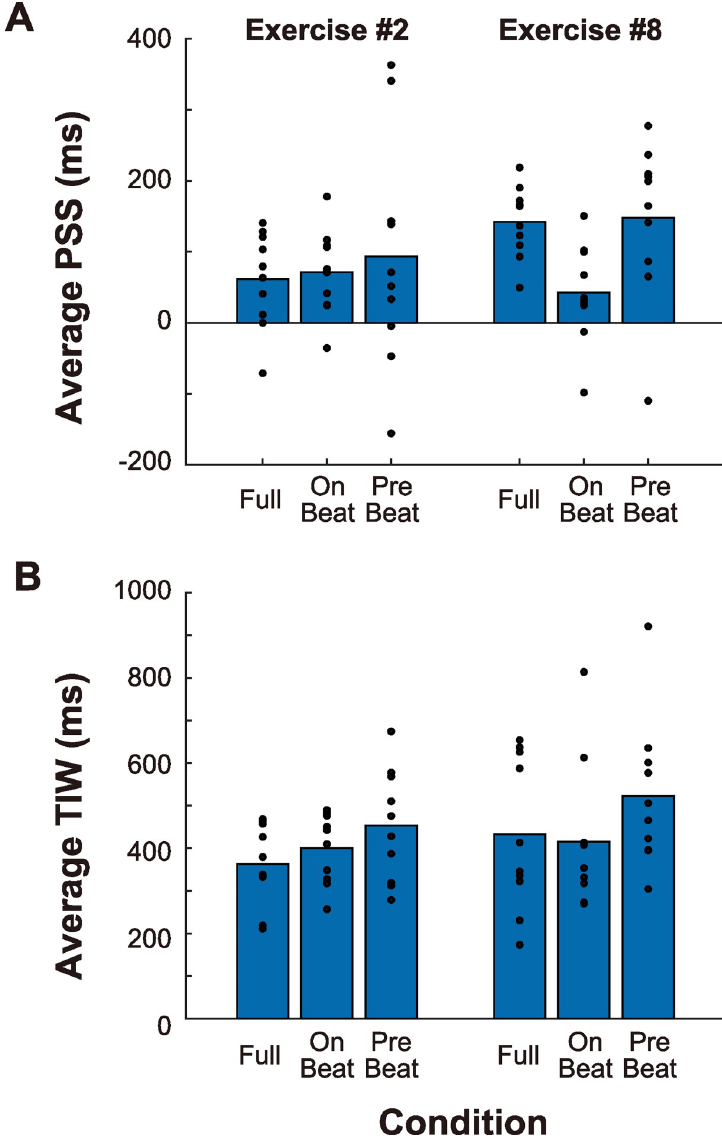
Fig 6. Point of subjective simultaneity (PSS) and temporal integration window (TIW) values in Experiment 2. Panels A and B summarize the average PSS and TIW values, respectively, estimated from the psychometric functions in Experiment 2. Small filled circles indicate data from individual